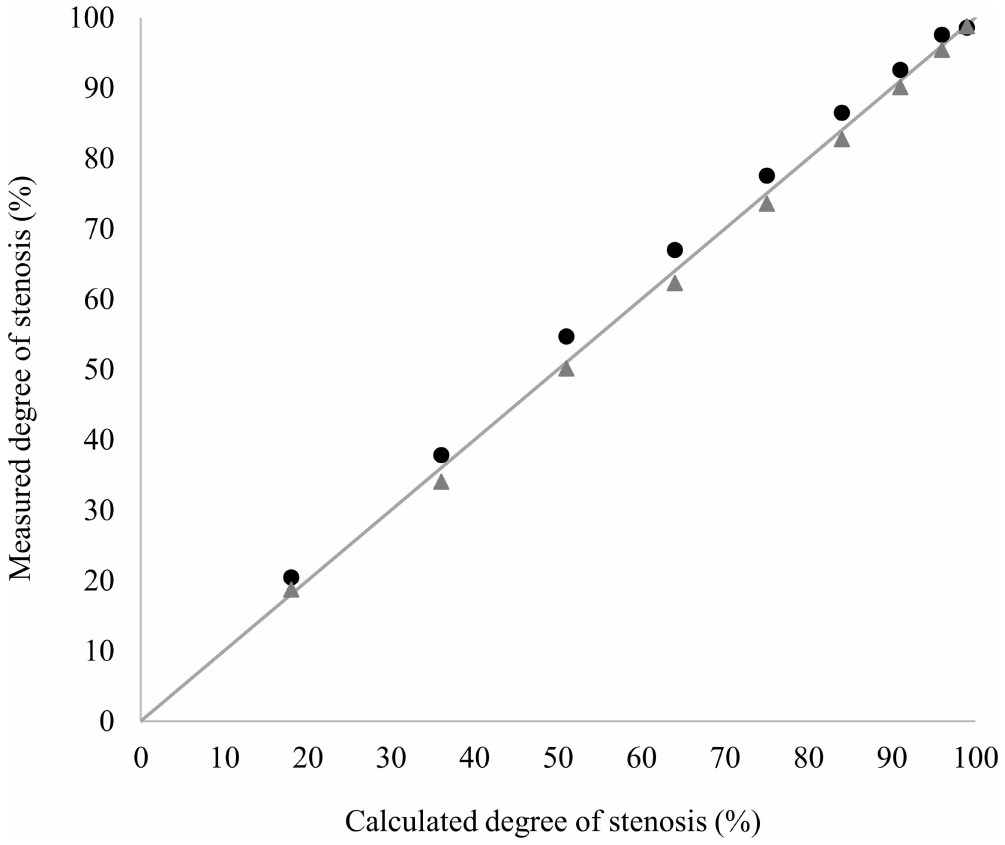
Fig 5. Scatterplot comparing the calculated and measureddegree of stenosis. The bisectrix indicatesthe ideal agreement of calculated(x-axis) and measured(y-axis) values. The values of the stenosis phantomsare indicatedas black dots and of the reference phantomsas grey triangles. The good agreementof the values can clearly be delineated.Please also see Table 1, Fig 6 and Fig